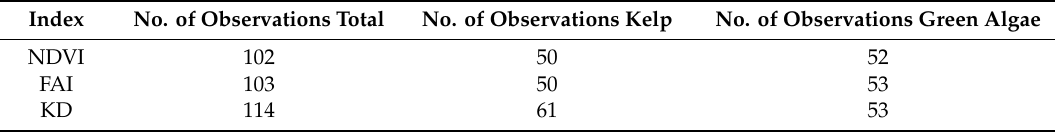
Table 4. Remaining grid cells out of 90 Giant kelp and 90 Green algae original observations (total = 180) after the application of the kelp filter algorithm to the training